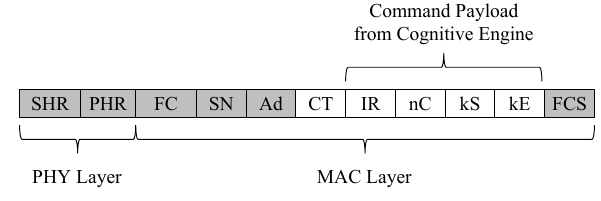
Figure 14. MAC command frame with ICOR result Our proposed protocol extension is the basis for the pair of transceivers to avoid an upcoming collision.